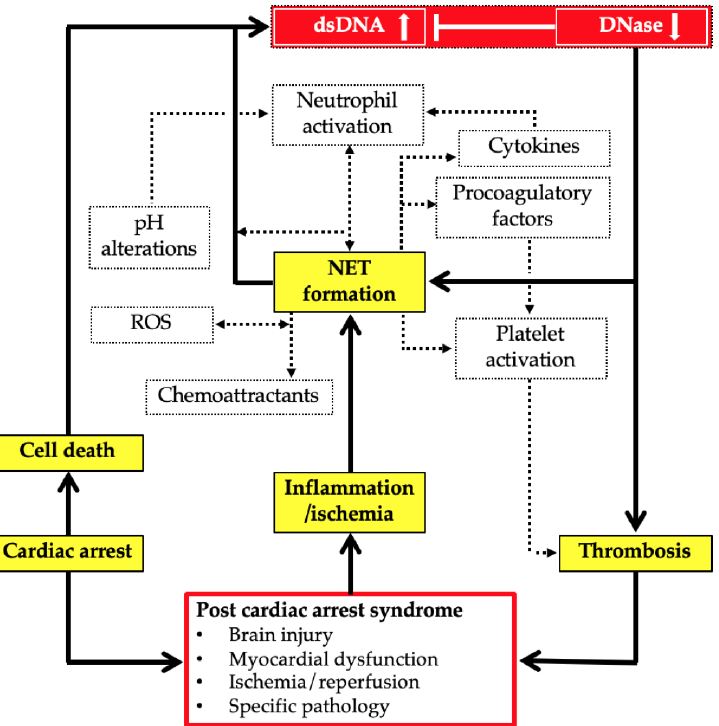
Figure 1. Schematic representation of the potential pathophysiological role of neutrophil extracellular traps (NETs) in post-cardiac arrest syndrome (PCAS). Abbreviations: DNase: deoxyribonuclease; dsDNA double-stranded DNA; NET: neutrophil extracellular traps; PCAS: post cardiac arrest syndrome; ROS: reactive oxygen species.